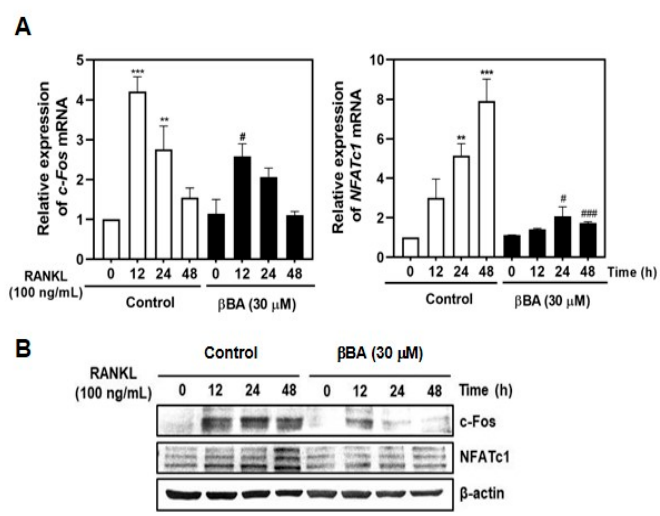
Figure 4. β -boswellic acid ( β BA) inhibits RANKL-induced c-Fos and NFATc1 expression. Mouse bone marrow-derived macrophages (BMMs) were incubated with M-CSF (30 ng/mL) and RANKL (100 ng/mL) in the presence or absence of β BA (30 μ g/mL) for the indicated time. DMSO was used as control. ( A ) Total RNA was isolated from cells using TRIzol reagent, and mRNA expression levels of c-Fos and NFATc1 were analyzed by real-time RT-PCR. Data represent means ± SD (n = 3). ** p < 0.01, *** p < 0.001 vs. control at 0 h; # p < 0.05, ### p < 0.001 as compared with DMSO control at the indicated time. ( B ) Protein expression levels of c-Fos and NFATc1 were evaluated by immunoblotting. β -actin was used as the internal control.